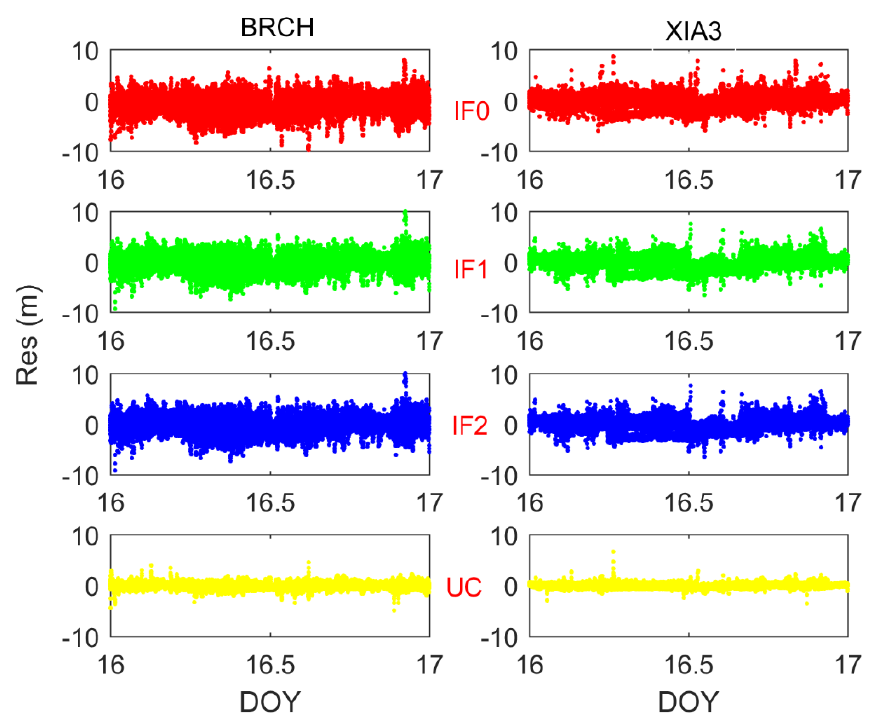
Figure 15. Analysis of the pseudorange observation residuals for all observed BDS-3 satellites for IF0, IF1, IF2, and UC model.